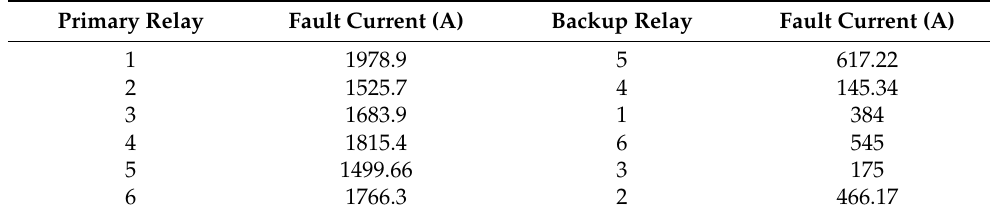
Table 15. Relationships between primary and backup relays and fault currents (IEEE 3-bus).